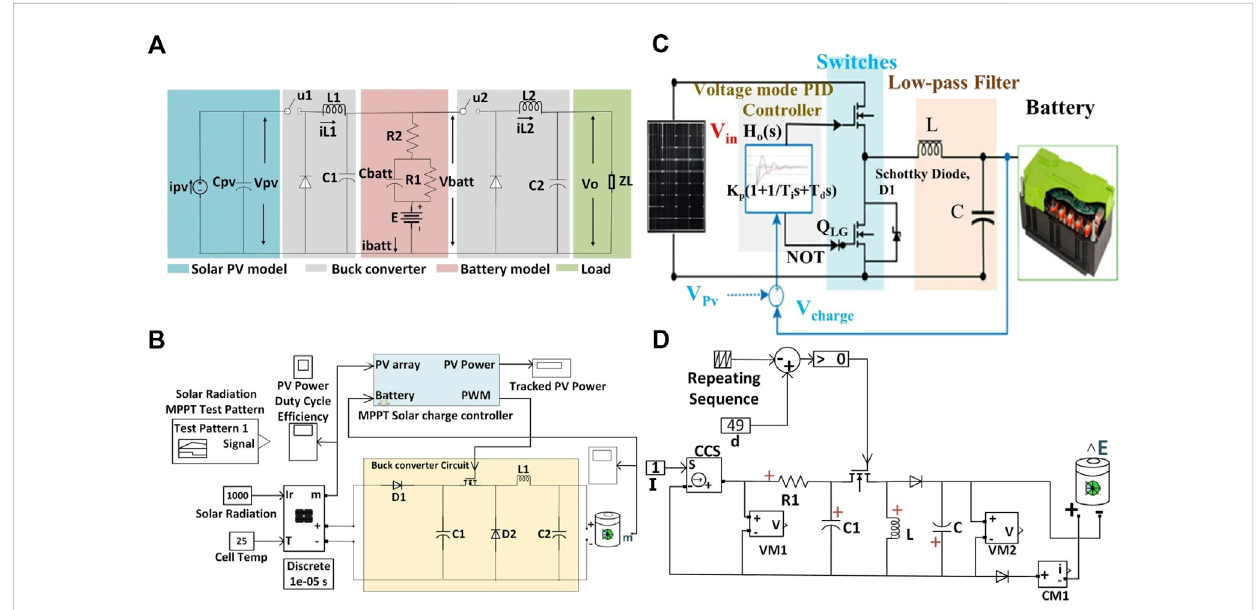
FIGURE 6 PV-Battery charge controller for (A) Hybrid electric and powertrain controller (Padmagirisan and Sankaranarayanan, 2019). (B) DC-DC buck topology and Perturb and Observe MPPT circuitry modeling for the standalone scheme (Tan et al., 2020). (C) PID controller with DC-DC buck converter (Chakraborty et al., 2018). (D) IoT-based P&O-based, MPPT, and buck-boost converter (Rokonuzzaman et al.,